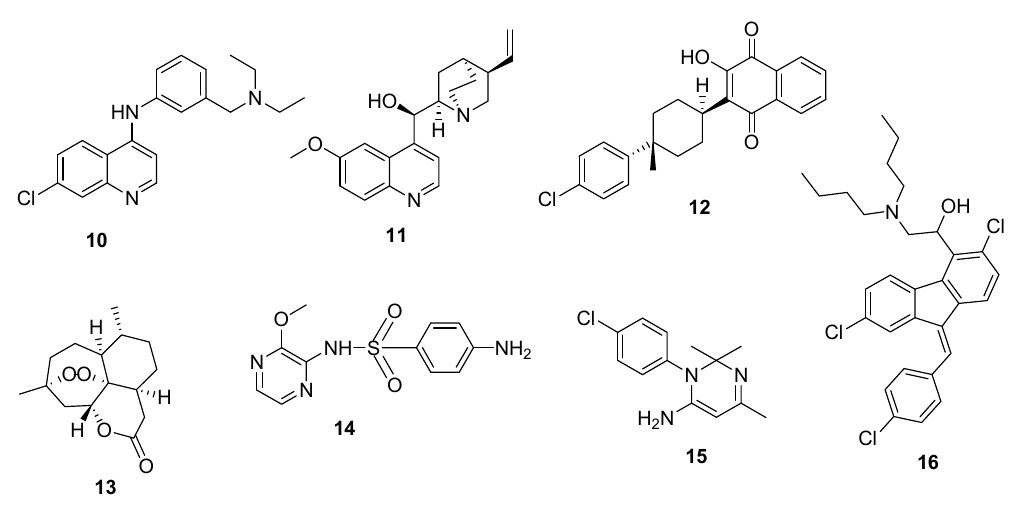
Figure 2. Examples of antimalarials classified based on their structure.